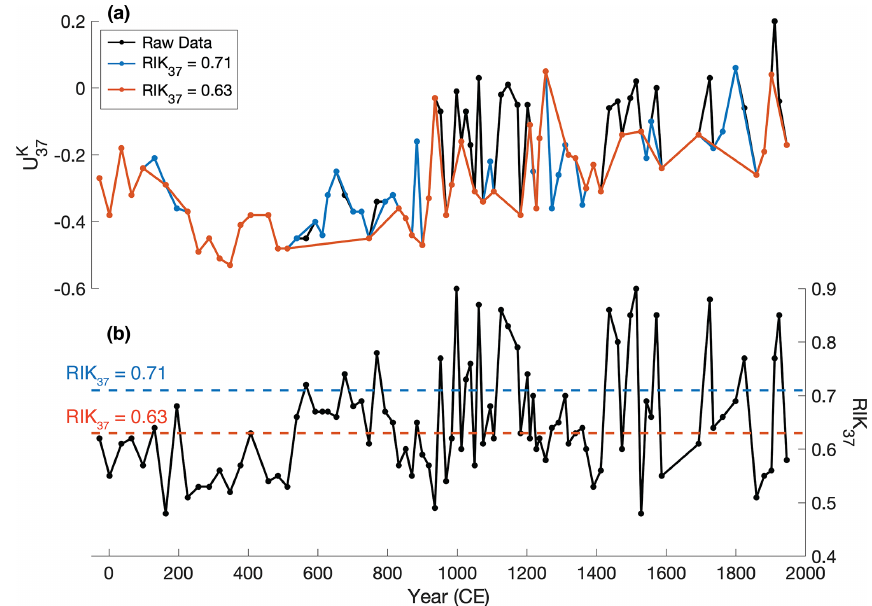
index is indicated in black, and the corrected U K Figure 3. (a) The raw data for the U K 37 in orange and blue, respectively. (b) The original RIK 37 index is shown below for comparison with the empirical cut-off, RIK 37 = 0 . 63, and cut-off for RIK 37 = 0 . 71 is indicated.